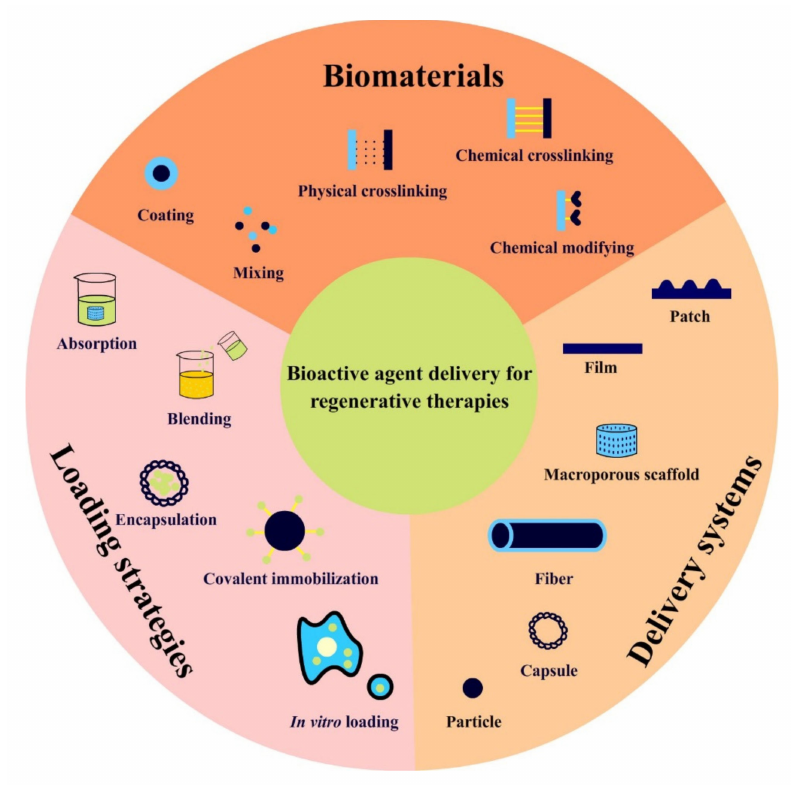
Figure 3. Overview of various delivery strategies for bioactive agent-based regenerative